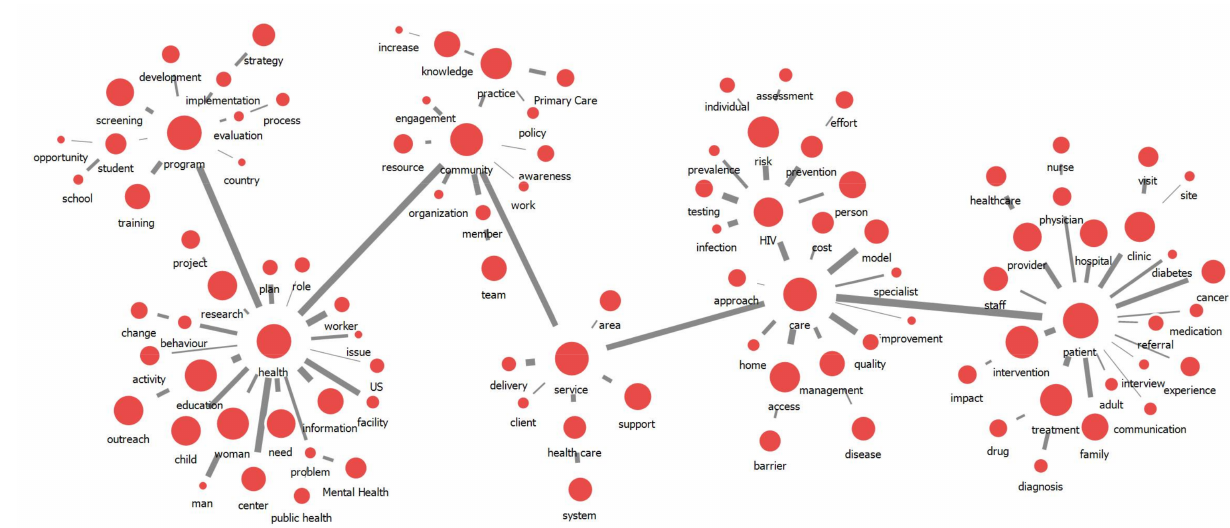
Figure 2. Overall knowledge structure for outreach research. The size of the node indicates the degree centrality of the keyword, and the width of the line indicates the strength of the link between keywords.